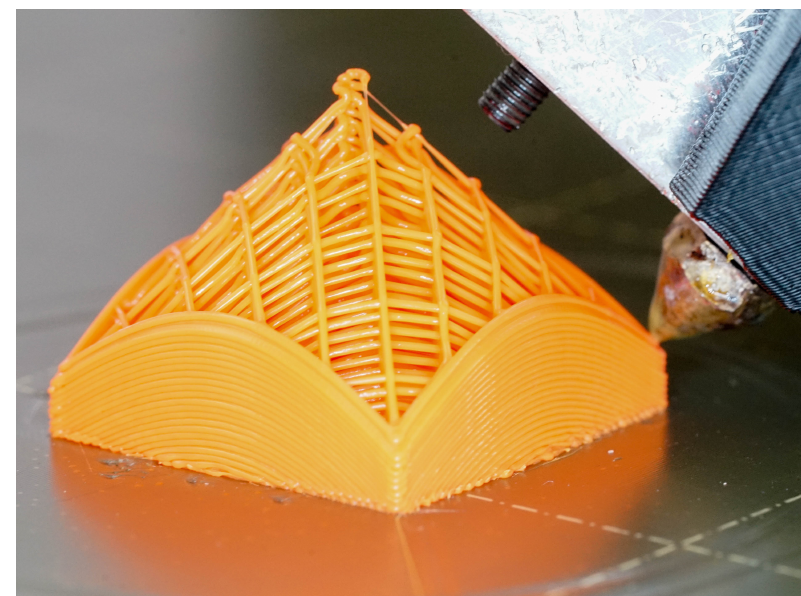
Figure 11. Printing a cube with a radial orientation of the nozzle.